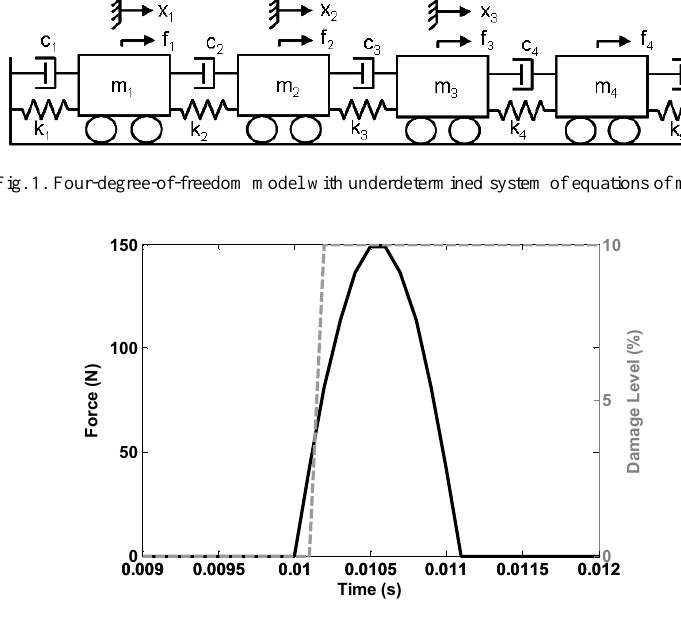
Fig. 2. Relationship between the applied force (——) and the damage level (– – –) of k 4 for the 4-DOF